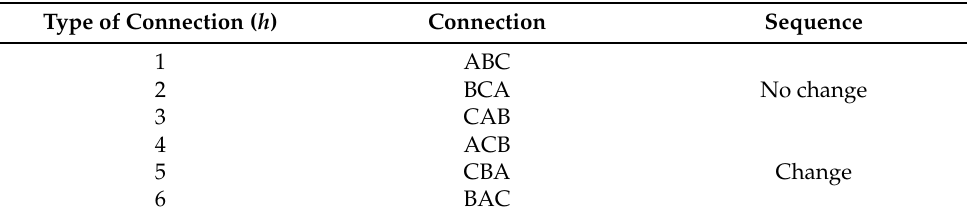
Table 3. Possible types of connections for the loads presented in the system [3].